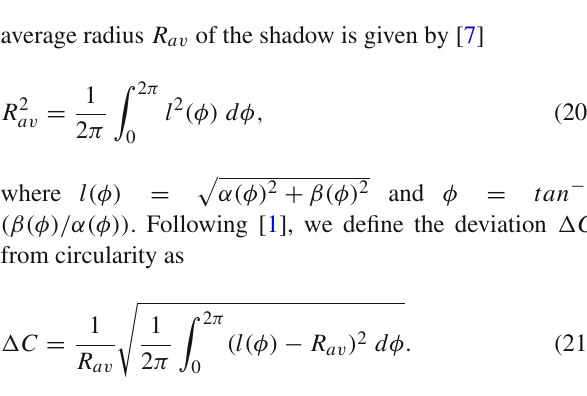
Fig. 5 Dependence of the diameter and deformation of the shadow on γ and θ o . Here, M = ( 6 . 5 ± 0 . 7 ) × 10 9 M (cid:13) and D = ( 16 . 8 ± 0 . 8 ) Mpc. The red dashed line shows the inclination angle θ o = 17 ◦ . Note that, for this inclination angle, the diameter and the deformation of the shadow are consistent with the M87 ∗ observation